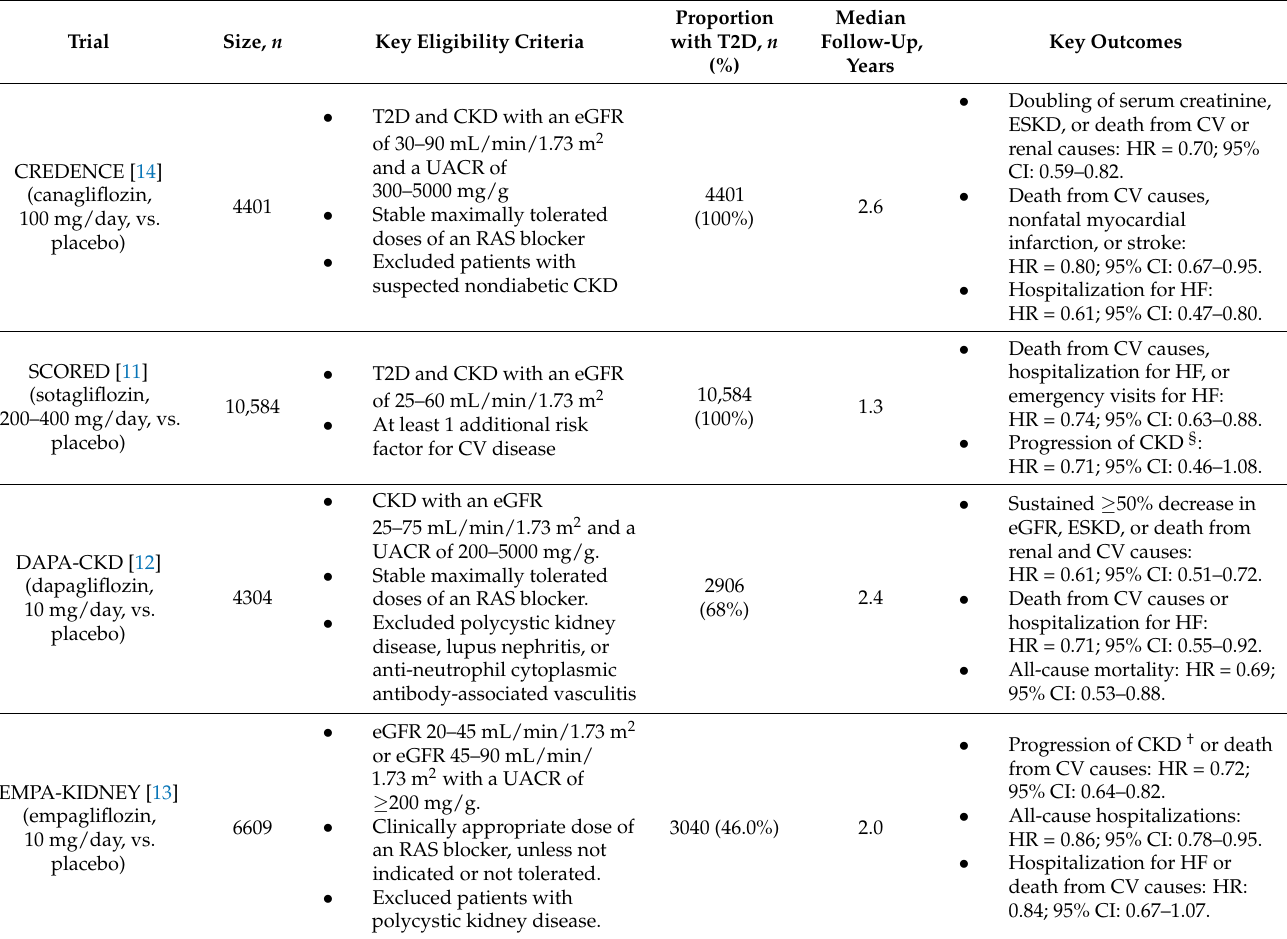
Table 1. The effect of SGLT-2 inhibitors on kidney and cardiovascular outcomes in randomized trials conducted in CKD patients with or without